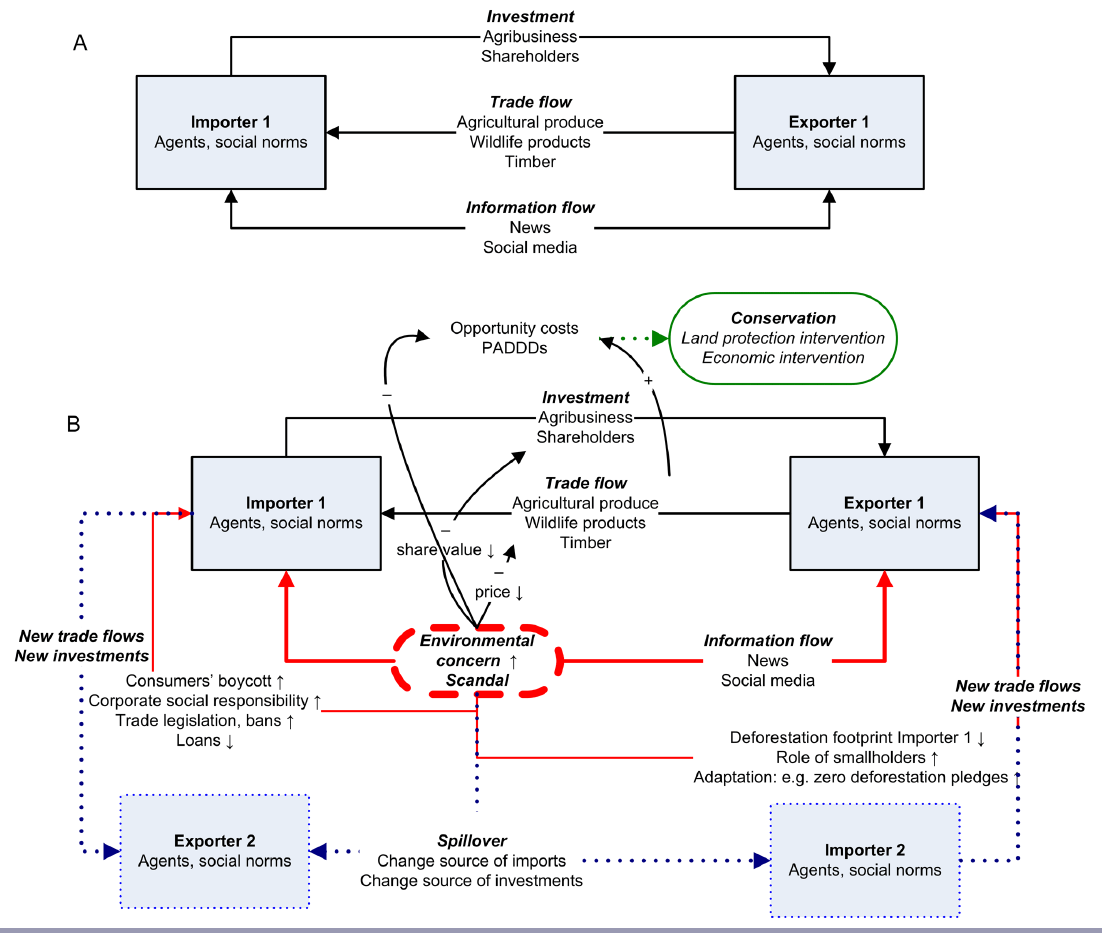
Fig. 2 . Conceptual framework describing the influence of telecoupling in investments, trade, and information on conservation strategies. (A) telecoupling of one importer and one exporter before growing environmental concern that modifies the information telecoupling. (B) Effects on telecouplings of a growing environmental concern or scandal (red dotted circle) spread by the telecoupled information systems. The scandal generates drops in telecoupled flows with adaptation from consumers, producers, and governments. Spillover effects to other exporters and importers through substitute products can further occur, creating opportunities and threats to conservation. PADDD: protected area downgrading, downsizing, and degazettment. Dotted lines indicated spillover effects. Red arrows indicate modification of the information telecoupling and subsequent direct